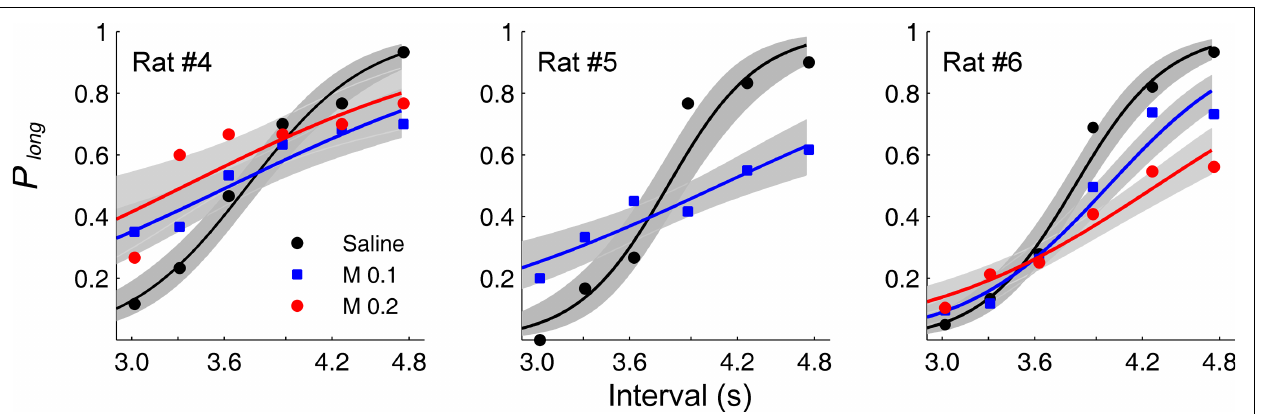
FIGURE 6 | Effect of mPFC inactivation on animal’s choice in the random-trial task. The proportion of long-target choices ( P duration under different drug treatment conditions for each animal. The solid lines were determined by logistic regression and the shading indicates 95% confi dence interval. M 0.1: muscimol 0.1 µg infusions; M 0.2: muscimol 0.2 µg